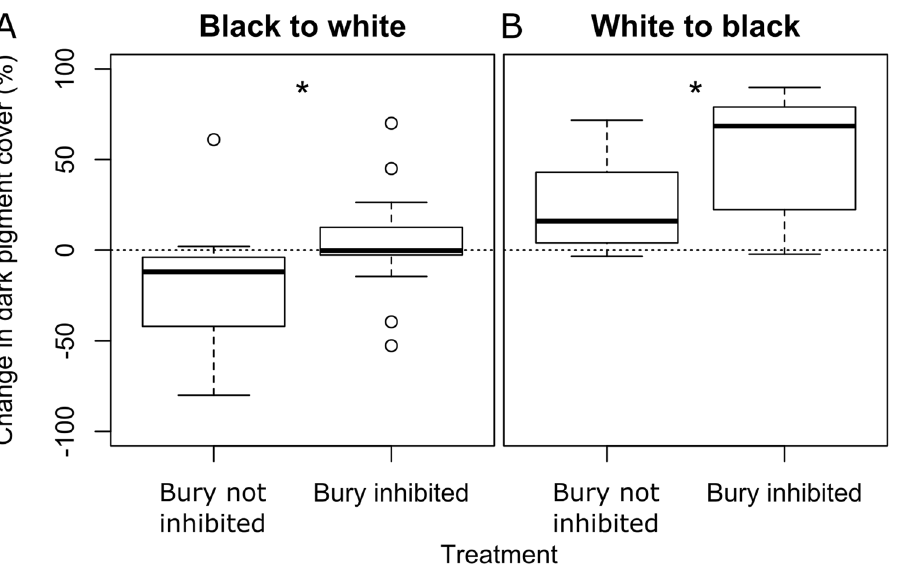
Figure 6. Effect of burying inhibition on Crangon crangon colour change. Box-and-whisker plots show the change in dark pigment cover within one hour of shrimp transferred to the opposite coloured background. ( A ) Shrimp were tested after acclimation on a black background and after being kept for one hour on a white background (N = 25). ( B ) Shrimp were tested after acclimation on a white background and after being kept for one hour on a black background (N = 22). The dashed line represents the level of no change. * P < 0.05. Change in pigment cover was calculated from PiC values shown in Figure